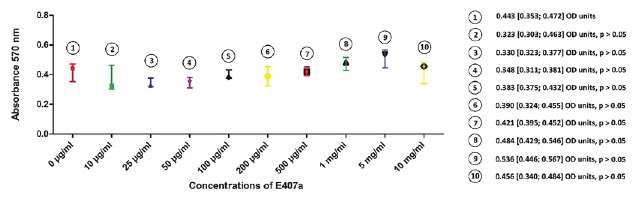
Figure 3 - The viability of fibroblasts exposed to E407a at concentrations 0-10 mg/ml for 24 h was assessed by neutral red uptake assay. Numerical data are presented in optical density (OD) units. The food additive E407a was not found to affect cell viability.